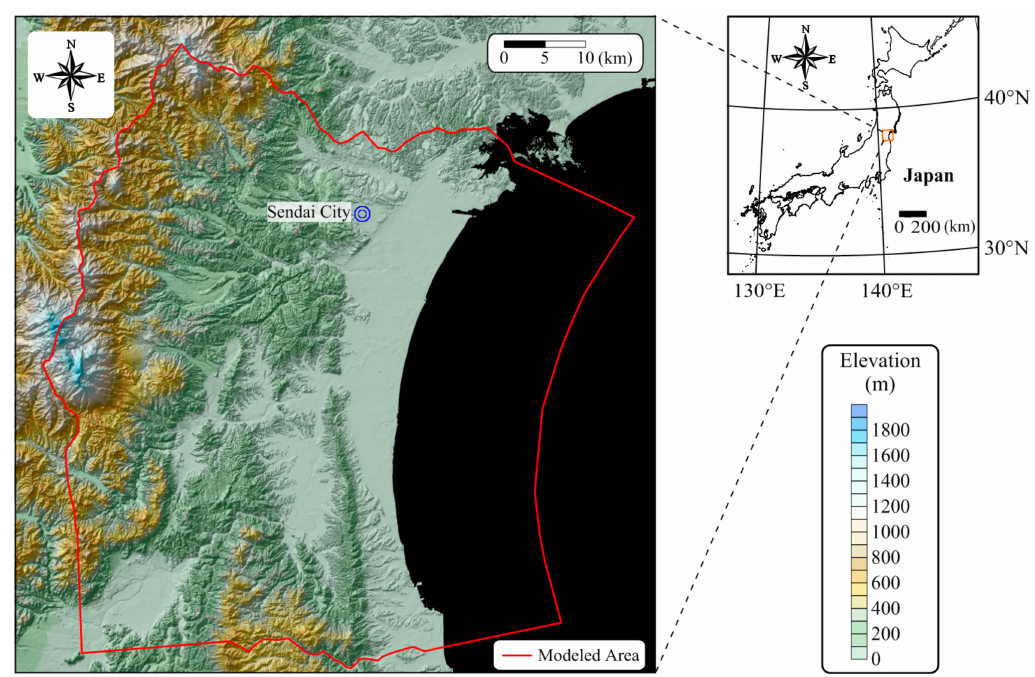
Figure 1. Study area and modeled area. The relief map and elevation data are drawn using the 10-m grid digital elevation map sourced from the Geospatial Information Authority of Japan